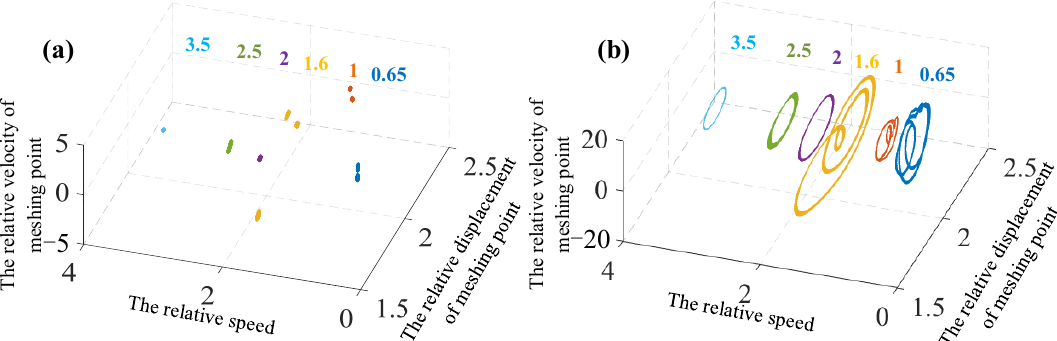
combined with Figure 20a,b, it can be observed that the system has experienced 2T-periodic, 3T-periodic, 1T-periodic, and quasi-double-periodic and motion states. Compared to the motion states when ζ = 0.01, the system changes from unstable quasi-periodic and chaotic motion to stable periodic motion; when ζ = 0.1 (Figure 21), the system presents stable periodic motion states. Therefore, under the influence of dynamic wear, the increase of damping ratio can also accelerate the energy loss of the system and make the system tend Figure 19. System response diagram with ζ = 0.01. ( a ) Poincare section diagram. ( b ) Phase diagram. to be stable.